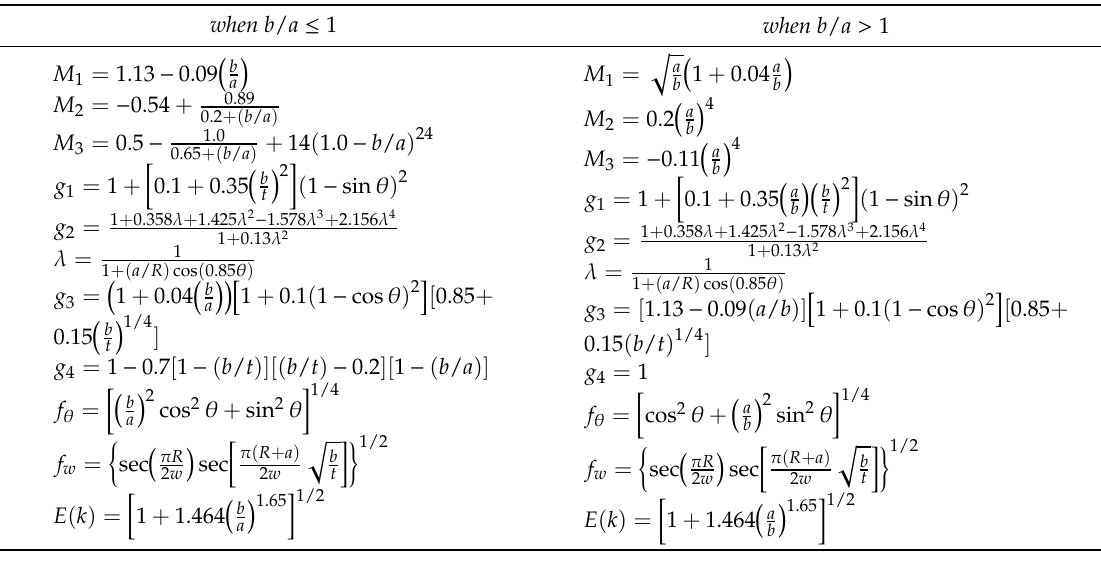
Figure 7. Geometry parameter definition of 3-D crack. Table 2. Empirical formula of the parameters in F I